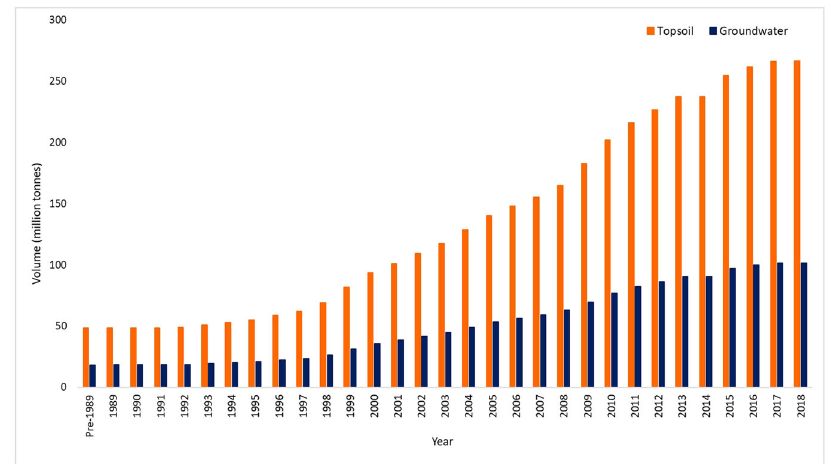
Fig. 6 Total estimates of topsoil and groundwater extraction in metric tonnes per year of assessment. Topsoil estimates are shown in red and groundwater extraction in blue.